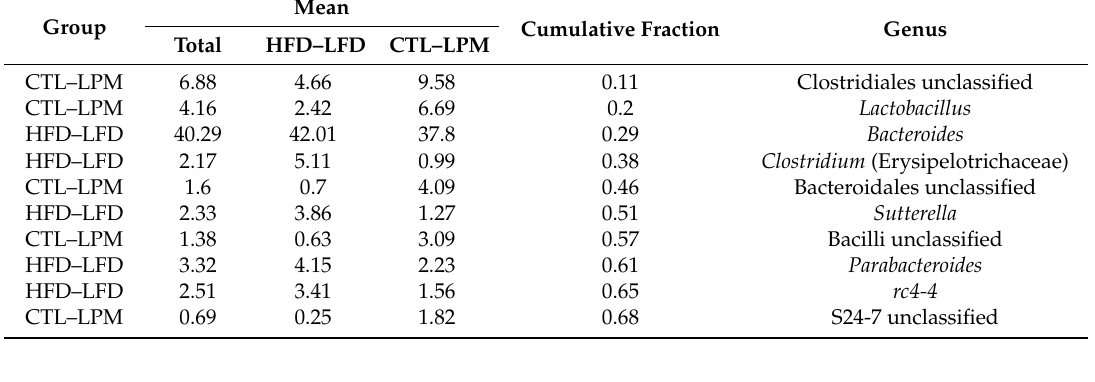
Table 1. Top 10 genera with higher differences in Dirichlet multinomial mixtures analysis. Mean Group Cumulative Fraction